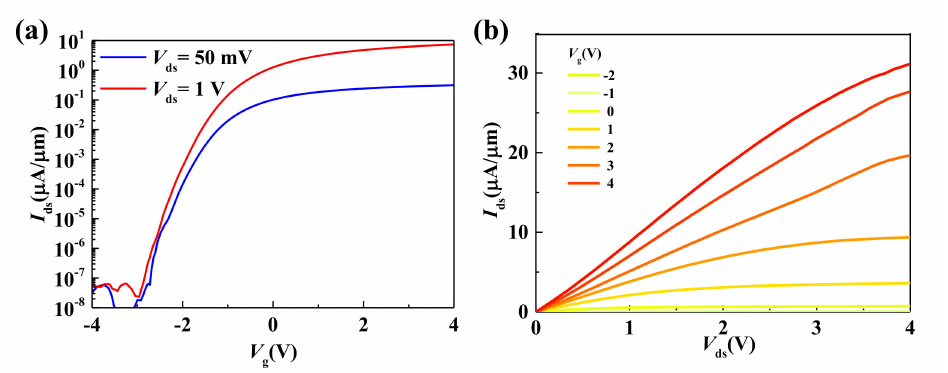
Figure 4. ( a ) Transfer characteristics at V ds = 50 mV and 1 V. I on / I off ratio are about 10 8 , making these devices ideal for ultra-low power applications. ( b ) Output characteristics of flexible CVD bilayer MoS 2 transistors at various V g